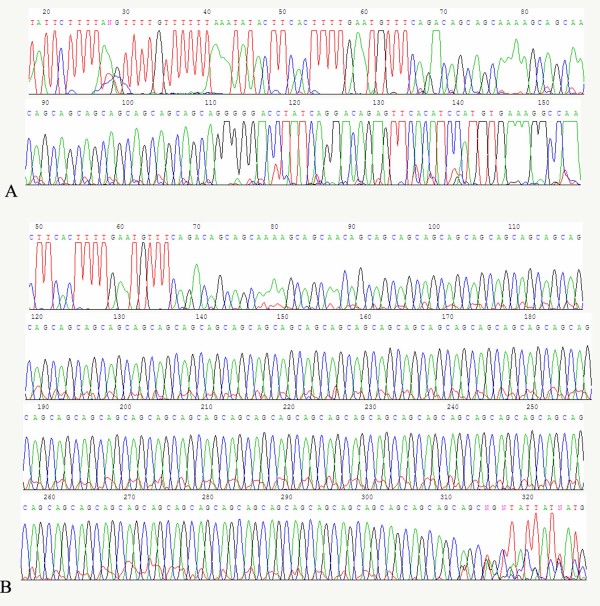
Chromatograms of the AN with 14 CAG (A) and the expanded allele with 81 CAG (B).